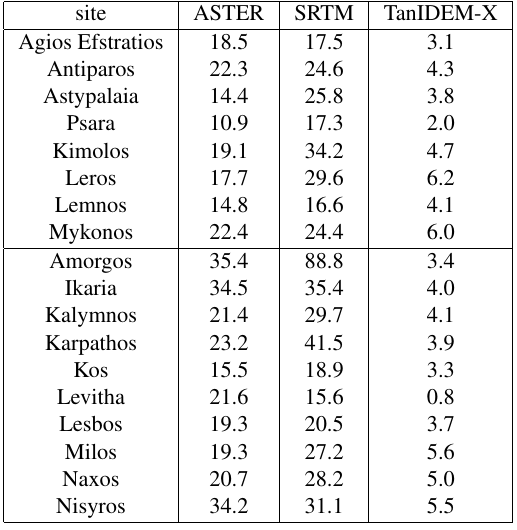
Table 4. RMSE (m) of the global DEMs with respect to local elevation data.